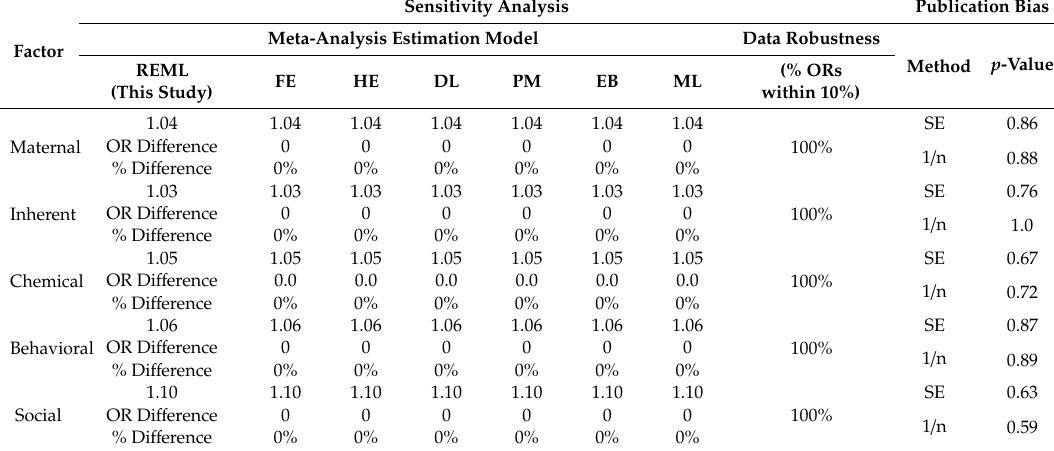
Table 2. The results of the sensitivity and publication bias analyses for the data analyzed in this publication. The Odds Ratio (OR) for each of the seven estimation methods are presented. The estimation methods were the restricted maximum likelihood (REML), the maximum likelihood (ML), the fixed-e ff ects (FE), the Hedges (HE), the DerSimonian–Laird (DL), the empirical Bayesian (EB), and the Paul–Mandel (PM) estimators. Standard error is denoted by SE, and the inverse of the sample size is denoted by 1 /